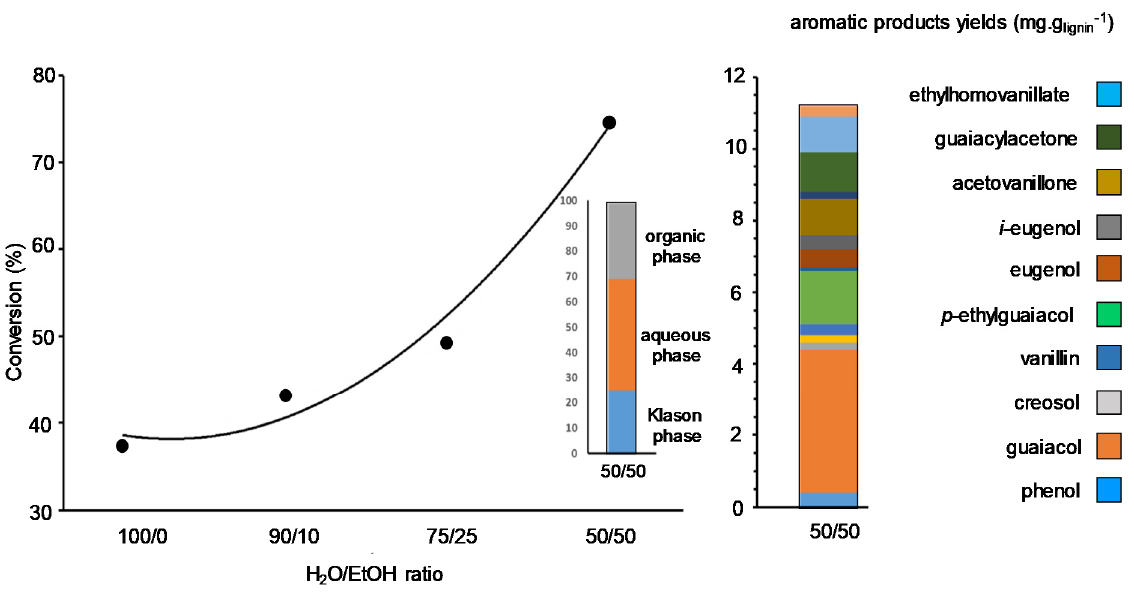
Figure 5. Influence of the water/ethanol mixture on lignin conversion with, after extraction, the phase repartition and the composition of the organic phase in the absence of catalyst.